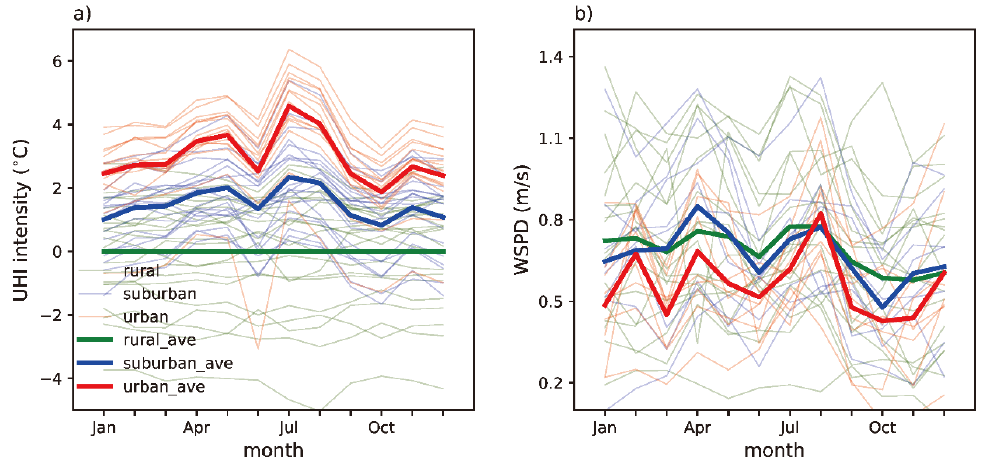
Figure 8. Mean UHI intensity ( ◦ C) at ( a ) suburban and ( b ) urban sites as a function of month and local standard time of the day.